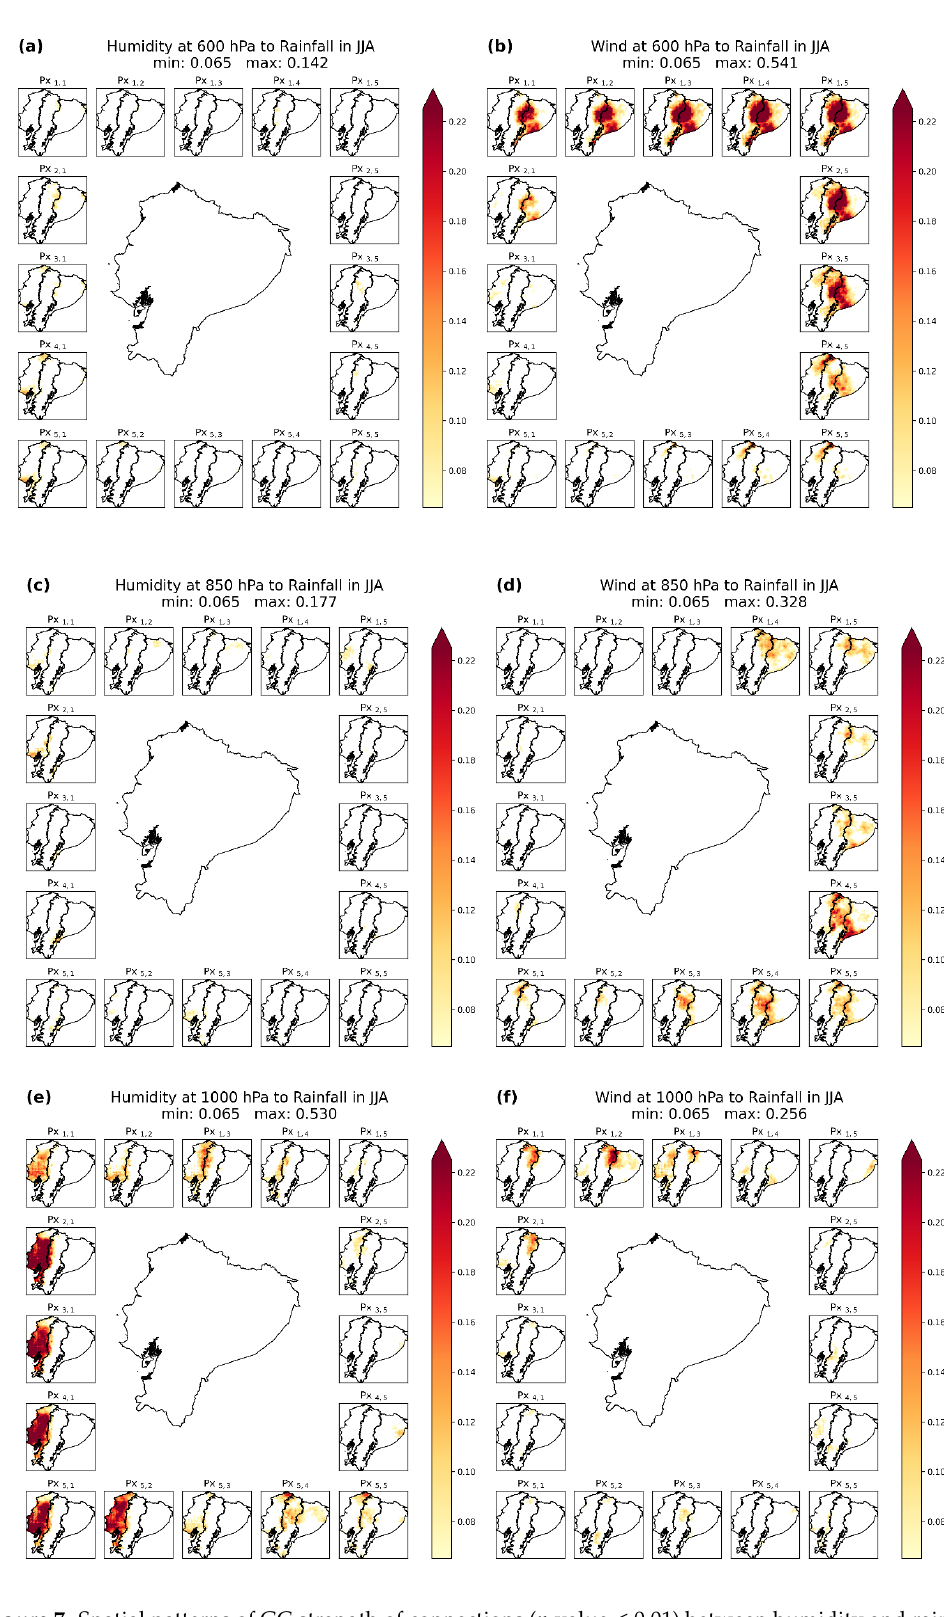
Figure 7. Spatial patterns of GC strength of connections ( p -value ≤ 0.01) between humidity and rainfall in JJA at ( a ) 600 hPa, ( c ) 850 hPa, and ( e ) 1000 hPa; and between wind and rainfall in JJA at ( b ) 600 hPa, ( d ) 850 hPa, and ( f ) 1000 hPa. ( d ) 850 hPa, and ( f ) 1000